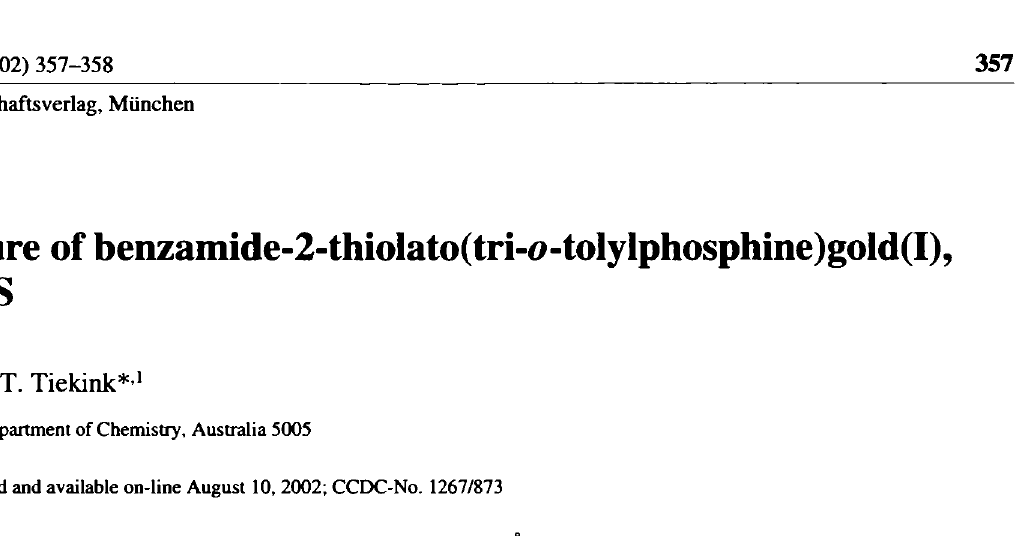
Table 1. Data collection and handling. Crystal: Wavelength: M- Diffractometer, scan mode: